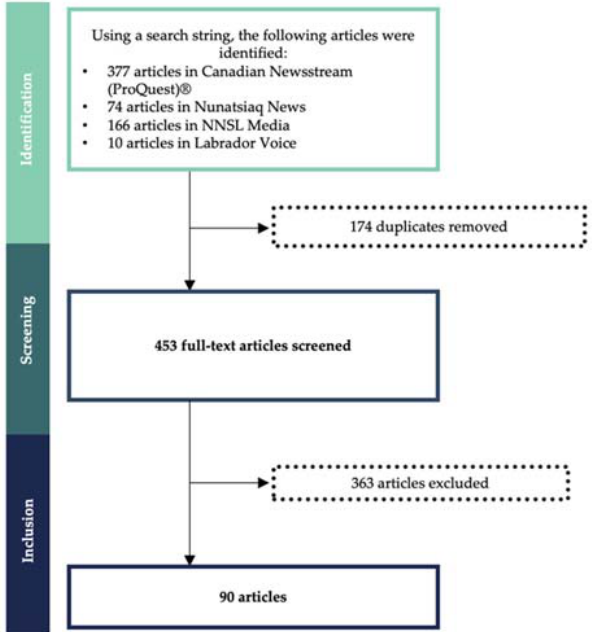
Figure 2. Flowchart of included articles on the mining industry’s initial response to COVID-19 in